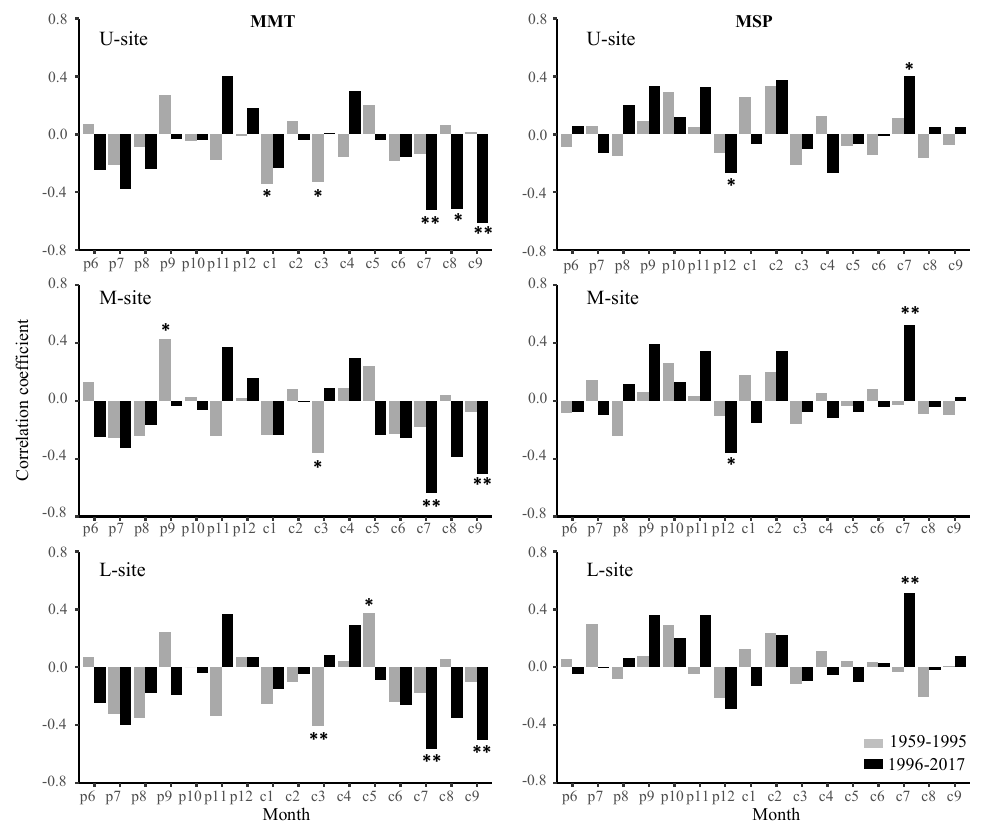
Figure 3. Correlation coefficients between the growth index and monthly climate for the previous June to current Sep ‐ tember (1959 − 1995 and 1996 − 2017). Star marks significant correlation (*, p < 0.05; **, p < 0.01). Three sample sites were L ‐ site at 2020 m, M ‐ site at 2090 m, and U ‐ site at 2220 m. The letter p before months indicates the months of previous year, and letter c indicates the months of current year. MMT, Monthly mean temperature; MSP, Monthly sum of precipitation.